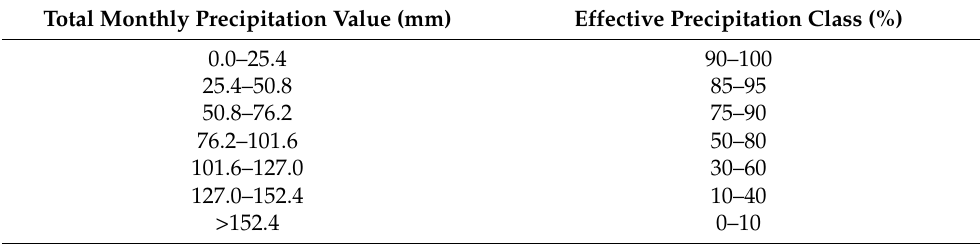
Table 2. Effective precipitation estimates, based on total monthly precipitation classes.